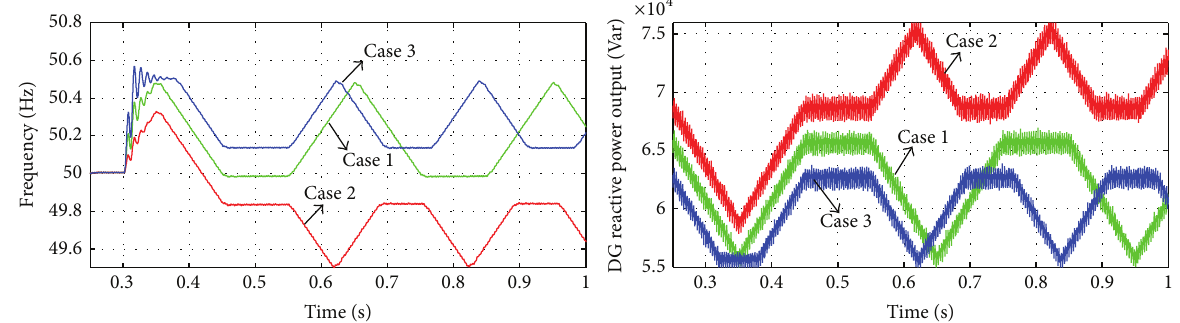
Figure 9: The PCC frequencies and reactive power output of the DG in the second scenario with the improved method.